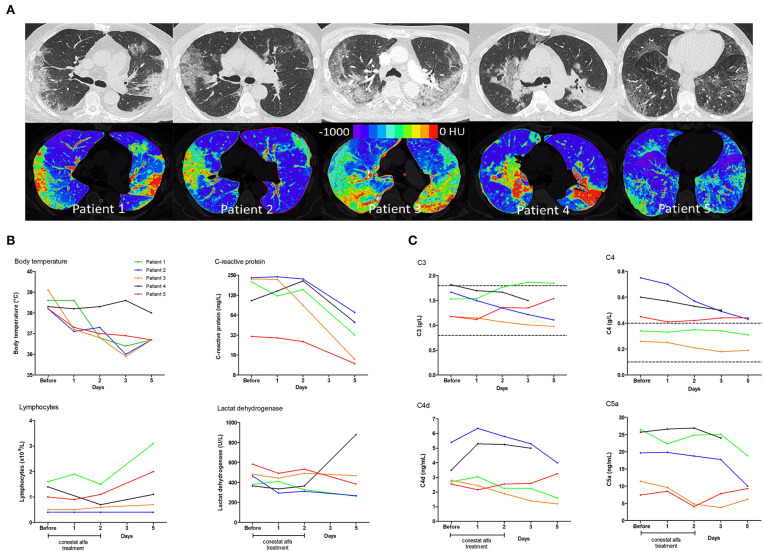
Chest computed tomography scans and temporal changes of laboratory parameters in five patients treated with conestat alfa. (A) Upper row: Original images in lung kernel reconstruction showing ground-glass opacities and consolidations involving multiple segments of both lungs with subpleural predominance. Lower row: color-coded maps from lung density analysis used to quantify the percentage of affected lung volume. (B) Temporal changes of body temperature, plasma C-reactive protein levels, lymphocyte counts and lactate dehydrogenase levels. (C) Temporal changes in concentration of serum complement component C3 and C4, and plasma activation products complement component C4d and C5a. Reference ranges are depicted by dashed lines.